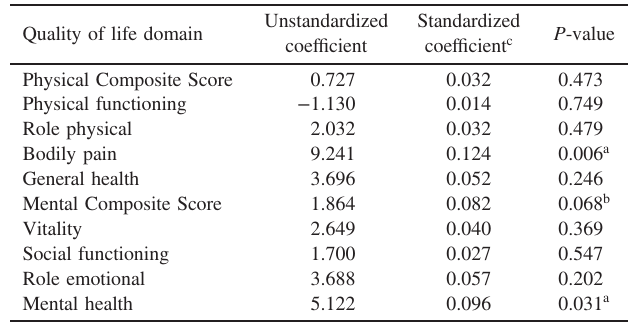
Table 5. Linear regression model of adjusted HRQOL measures